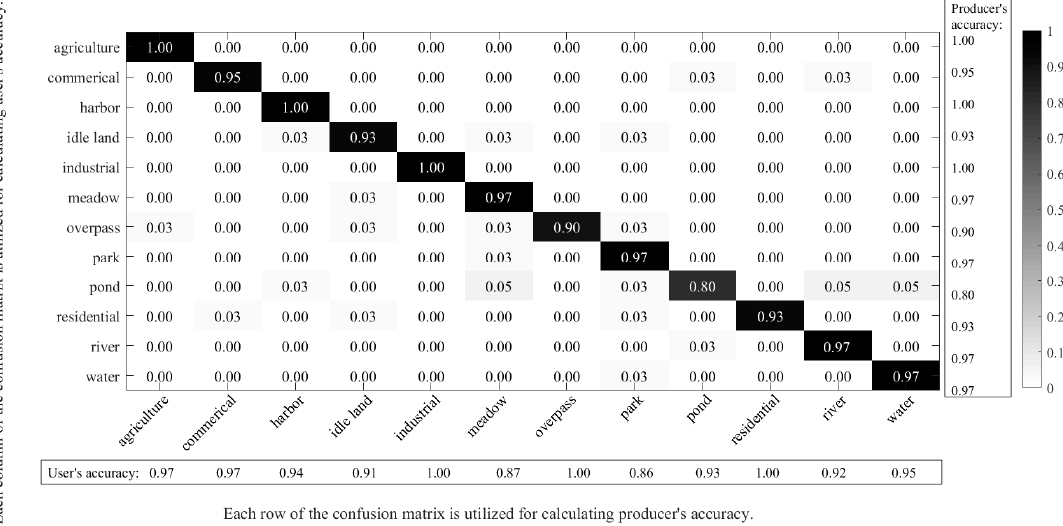
Figure 11. Classification accuracies of each category for different algorithms with the Google image dataset of SIRI-WHU. From Figure 11, it can be seen that the pre-trained AlexNet-SPP-SS model obtains a better classification accuracy than the pre-trained AlexNet, the pre-trained AlexNet-SPP, and the pre- trained AlexNet-SS, in an overall view. However, the classes of meadow and pond obtain a worse classification accuracy as they contain confusing scene images that are similar to agriculture and river, respectively. Taking a more in-depth and detailed analysis of the classification accuracy for certain classes, for example, all the classes except for the harbor and park classes, it can be seen that a better classification performances when adopting the SPP strategy. This is mainly due to the performance promotion of the SPP strategy considering multi-scale information of the HSR remote